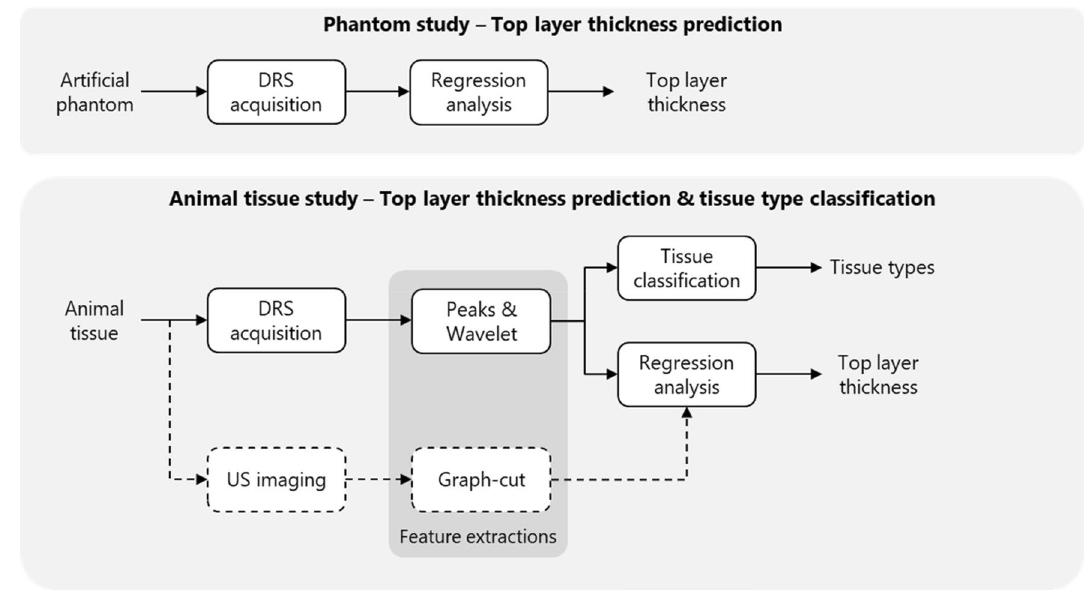
Figure 2. Workflow of data acquisition and data analysis for the top layer thickness estimation and tissue type classification. In the phantom study, DRS data was used as input for regression analysis, in which the top layer thickness was predicted. In the animal tissue study, two types of features were extracted from the DRS data. These features were used in a classification analysis to predict the tissue type of both the 1st and 2nd tissue layer and in a regression analysis to predict the top layer thickness. In addition, these results were compared to the results of using US imaging and using both techniques combined. Therefore, US images were acquired and structural features were extracted based on a graph-cut method.